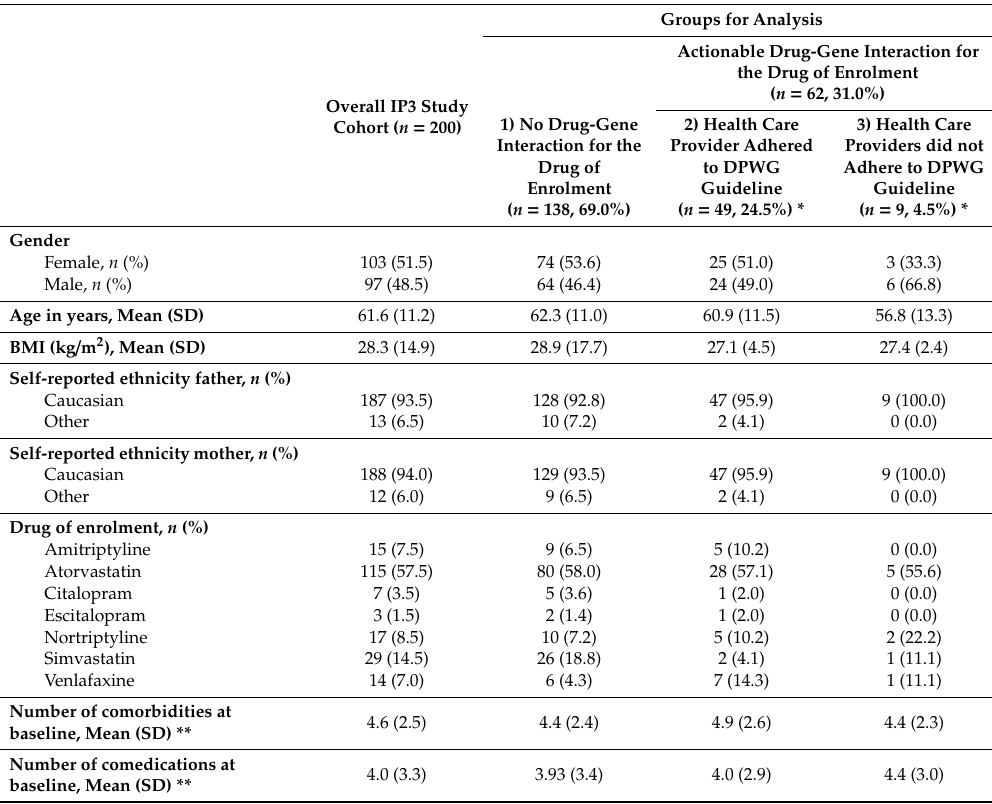
Table 1. Summary of patient characteristics in Implementation of Pharmacogenetics into Primary care